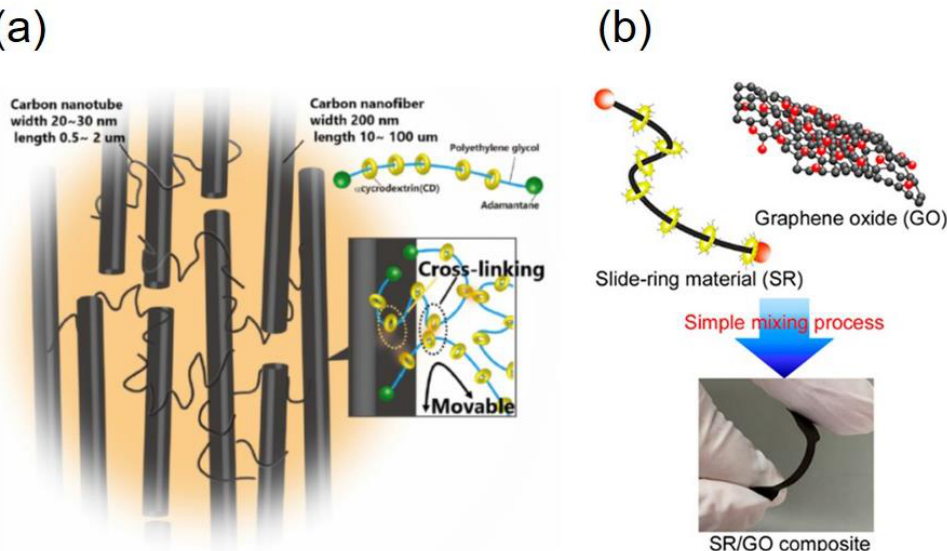
Figure 23. Schematic illustration of ( a ) SR elastomers with plasma-surface-modified carbon nanofiber (CNF)/carbon nano-tube (CNT) [43] and ( b ) SR graphene oxide (GO) composites with high electrical conductivity and mechanical toughness [44]. Reprinted from [44] and [45] with permission from Elsevier and American Chemical Society, respectively.